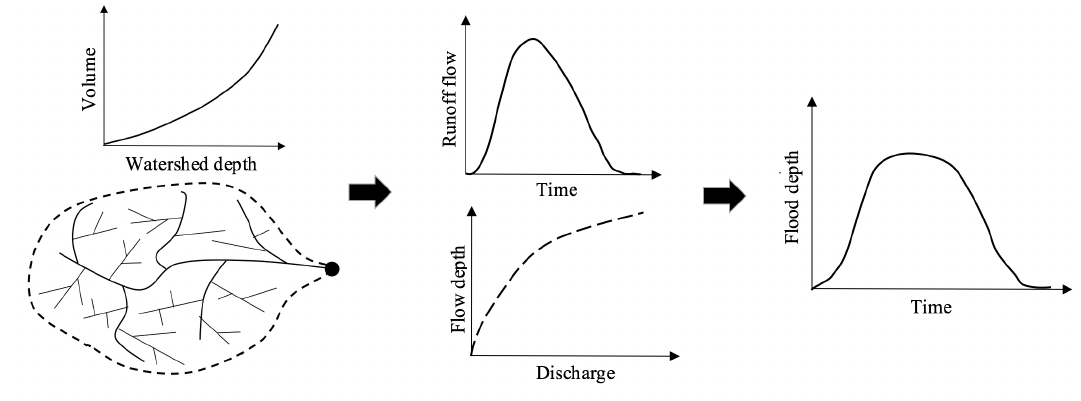
Figure 4. Graphical representation of inundation estimation process; typical runoff hydrograph ( upper middle side ); inlet stage-discharge curve ( lower middle side ); stage-volume curve ( upper left corner ); and flood depth vs. time curve ( right corner